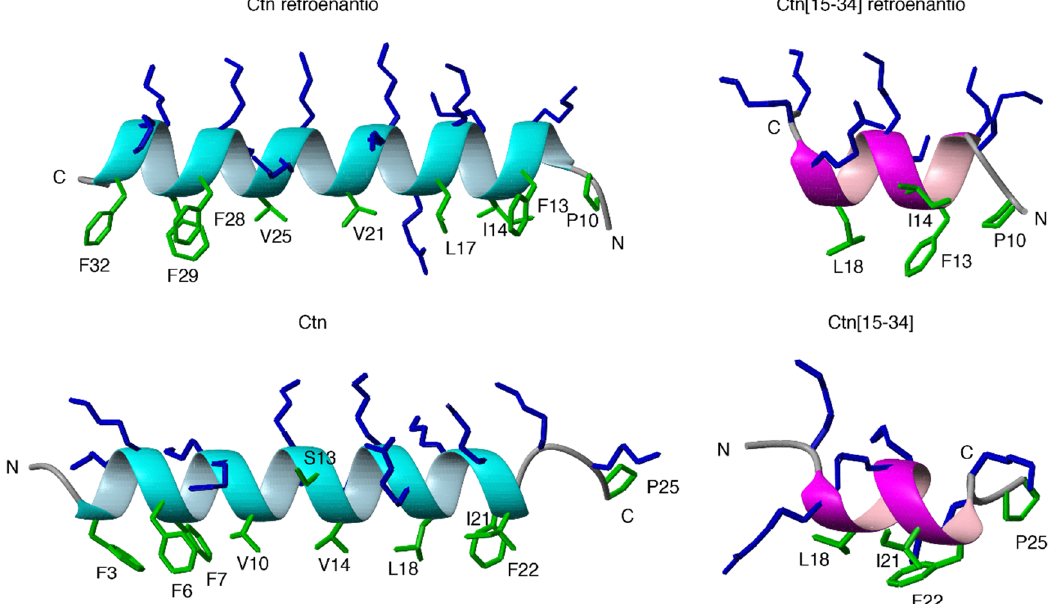
Figure 6. Ribbon representations of helical regions determined by NMR of Ctn retroenantio ( left , top ), Ctn ( left , bottom ), Ctn[15-34] retroenantio ( right , top ), and Ctn[15-34] ( right , bottom ) peptides. Arg and Lys side chains are shown in blue, and all other side chains are shown in green. N- and C-termini as well as hydrophobic side chains are labeled.